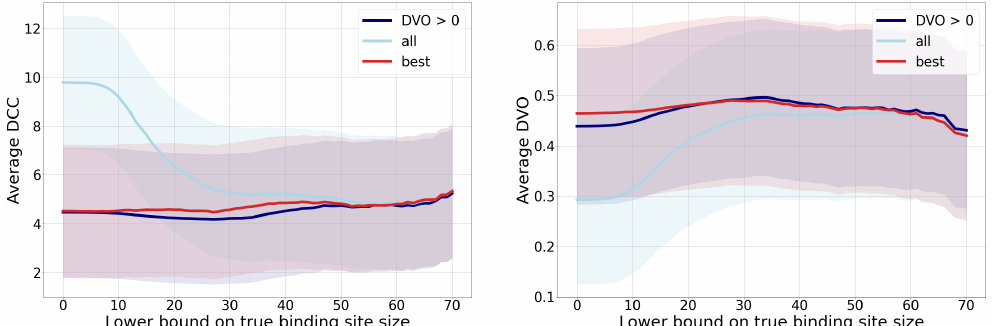
Figure 9. Performance comparison of binding site detection depending on the lower bound on true binding site size. The left graph displays an average distance to the true binding site distance (DCC) (less is better), and the right graph displays the discrete volumetric overlap (DVO) (more is better). Each graph contains three curves for three groups of observed binding sites: for all binding sites, the best in each chain, and for those with DVO > 0. The intervals (stripes) around the curves denote the standard deviations of each value—the width of each stripe is two standard deviations. Although the deviations seem large, the absolute values they represent in each metric are